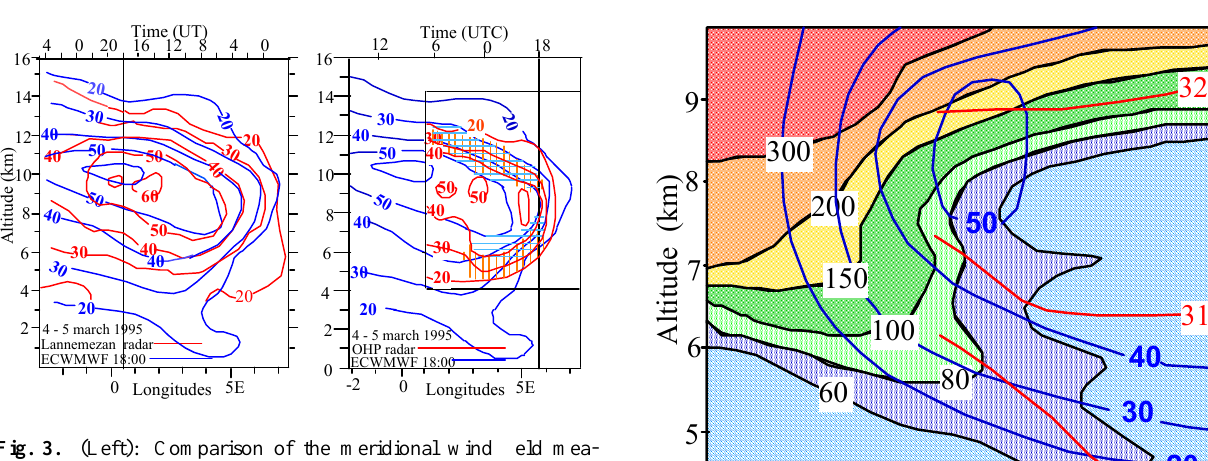
Fig. 3. (Left): Comparison of the meridional wind field mea- sured on 4 March 1995 by the Lannemezan radar with the ECMWF meridional wind field in a west-east vertical cross section contain- ing the radar site for the same day at 1800 UTC. (Right): Same comparison with the wind field measured by the OHP radar. The horizontal (blue) and vertical (red) lines indicate the region where the wind shears S are greater than 10 − 2 m − 1 in the ECMWF model and for the observed wind field, respectively.